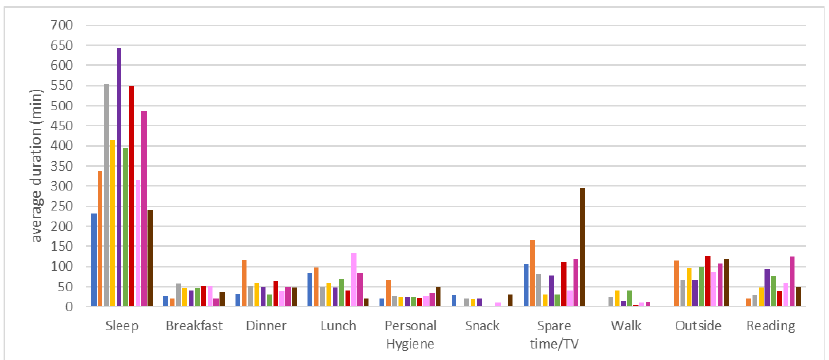
Figure 8. The average duration of each ADL per person. Different colors are used for different persons: blue for id = 1, orange for id = 2, gray for id = 3, yellow for id = 4, lilac for id = 5, green for id = 6, red for id = 7, pink for id = 8, fuchsia for id = 9, brown for id =